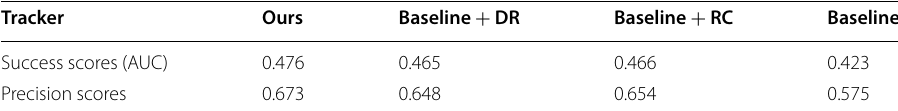
Table 4 Ablation analysis on the UAV123@10fps dataset